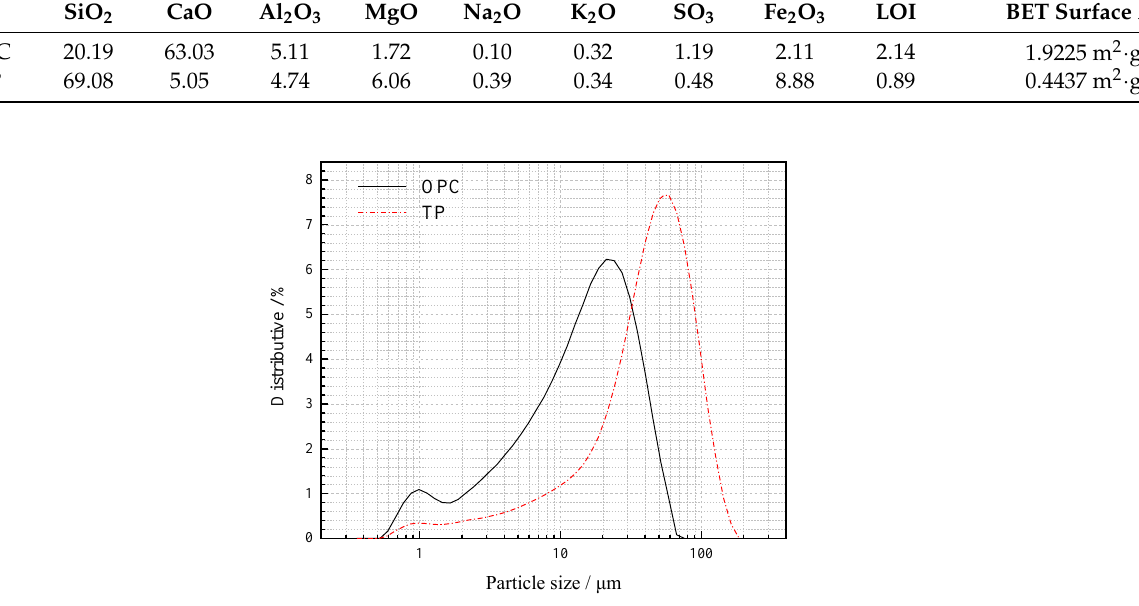
Figure 1. Particle size distribution comparison among TPs and cement.